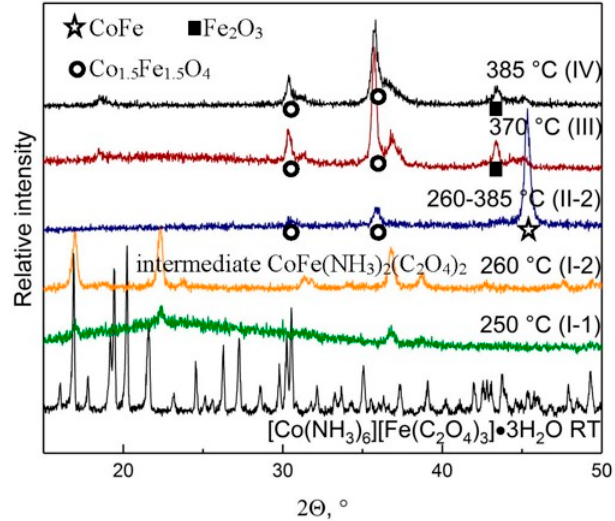
Figure 4. Diffractograms of the precursor salt [Co(NH 3 ) 6 ][Fe(C 2 O 4 ) 3 ] · 3H 2 O, intermediates I–III, and final product IV.